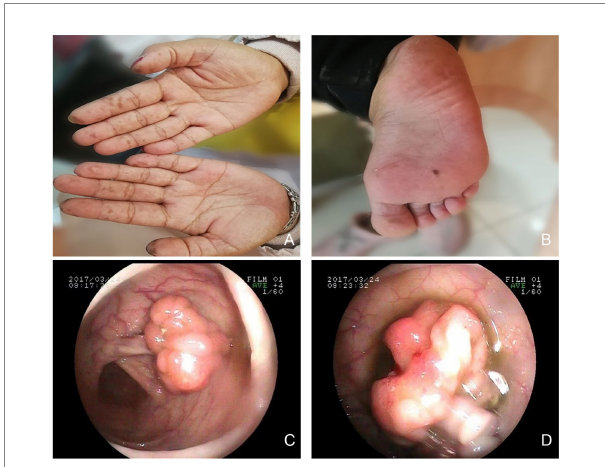
FIGURE 1 Multiple hyperpigmentations were visible on the skin. (A) hands. (B) right foot. Gastrointestinal endoscopy revealed multiple polyps. (C) small bowel. (D) ileum.